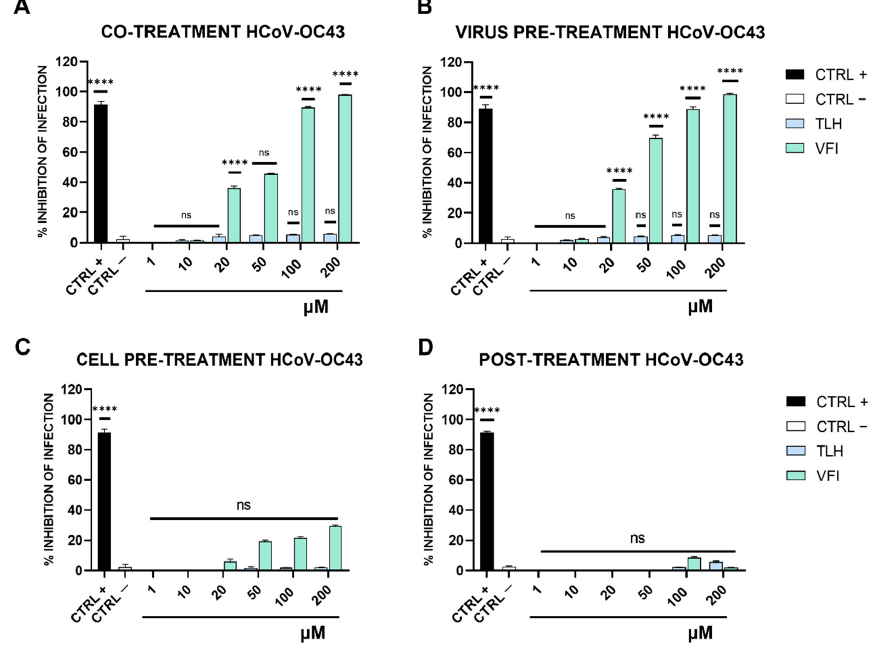
Figure 3. Antiviral activity of tripeptides against human coronavirus OC43. ( A ) co-treatment; ( B ) virus pre-treatment; ( C ) cell pre-treatment; ( D ) post-treatment. CTRL+ refers to positive control (ivermectin 12 μ M) and CTRL—indicates the negative control (only infected cells); **** p ≤ 0.0001; ns: non-significant.